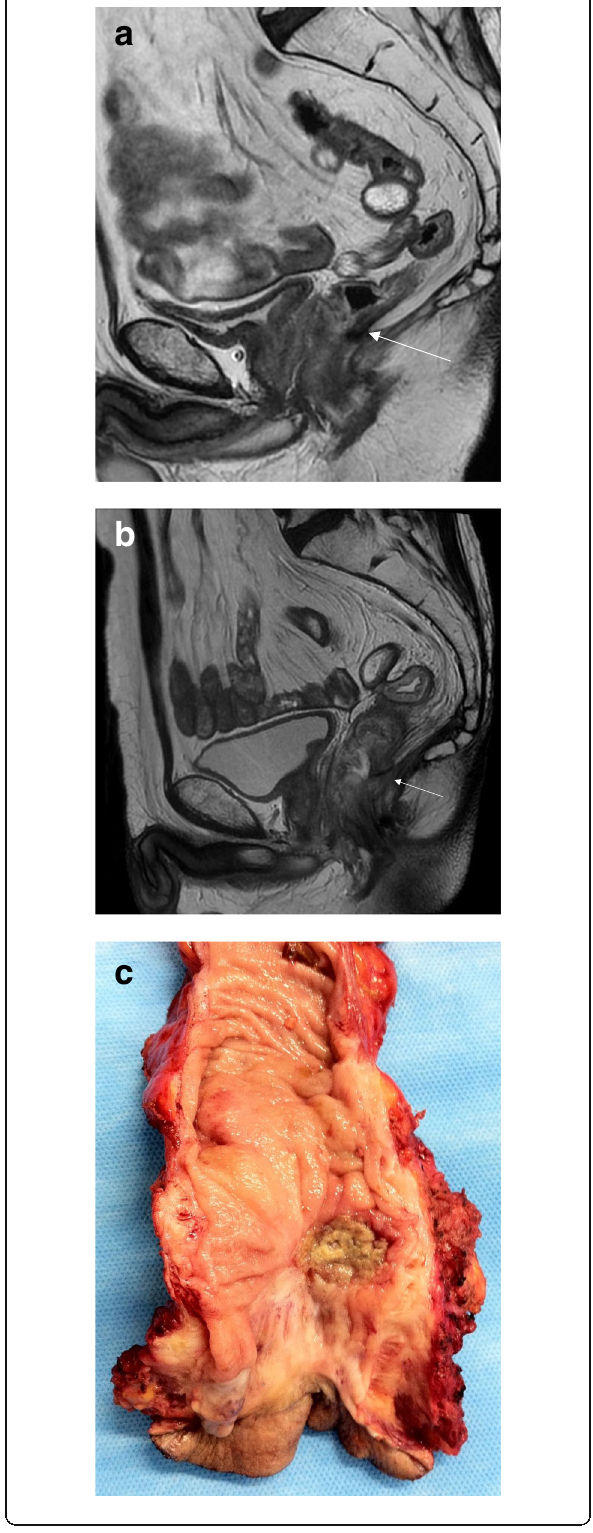
Fig. 15 Low rectal lesion with luminal and mesorectal regrowth. a High-resolution sagittal T2WI shows the posterior low signal intensity scar (arrow). b Follow-up exam after 5 months showed increased signal intensity within the scar and extension to the intersphincteric plane (arrow). c The specimen shows the luminal lesion close to the anal verge. Extralevator APR was required and performed with coccygeal resection. Final pathological